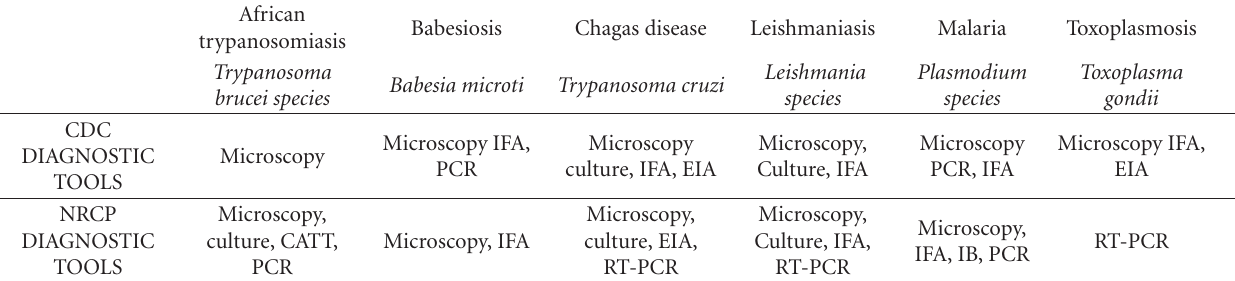
Table 3: Diagnostic tools for the detection of specific blood-borne parasitic diseases o ff ered by the CDC and the